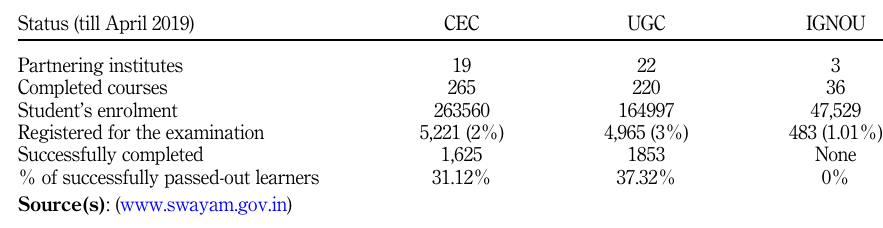
offered through CEC, UGC and IGNOU